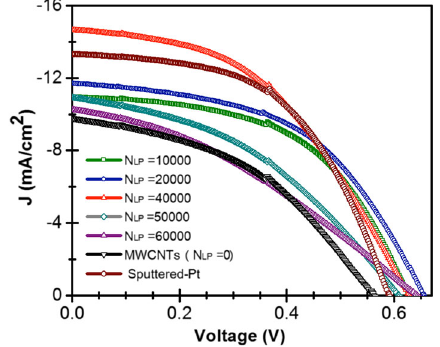
Fig. 5 Typical J–V characteristics, measured under AM 1.5 solar illumination, of the DSSC devices made with pristine MWCNTs, sputtered-Pt and Co–Ni NPs decorated MWCNTs counter electrodes (at different N LP ranging from 10,000 to